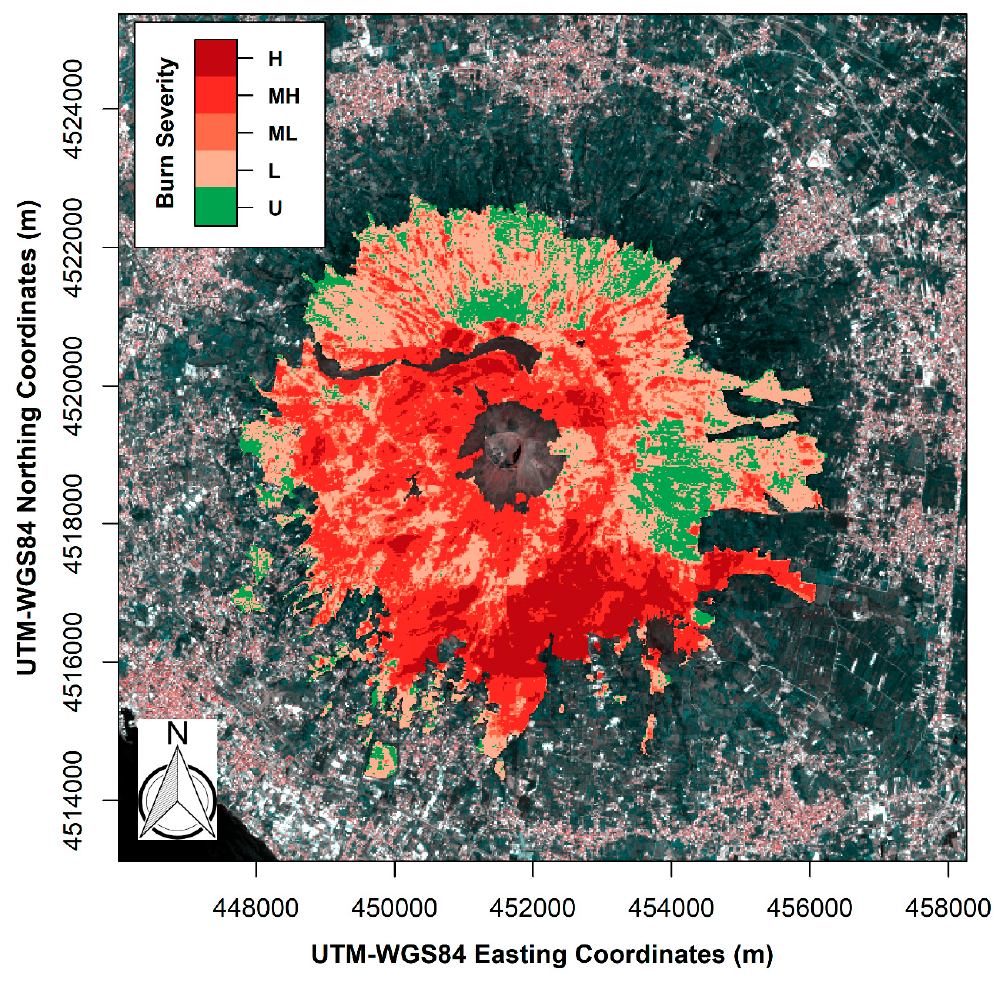
Figure 4. Burn severity map of Vesuvius National Park after the summer wildfires occurring in 2017. The capital letters H, MH, ML, L, and U correspond, respectively, to the following burn severity classes: